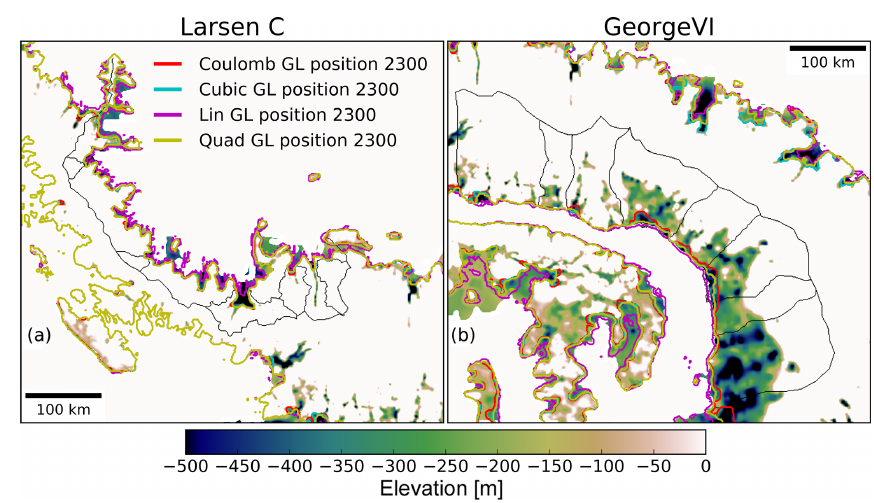
Figure A7. Comparison of modelled grounding-line positions using BISICLES with different basal sliding laws for Larsen C (a) and George VI embayments (b) . Black lines denote modelled drainage basins.